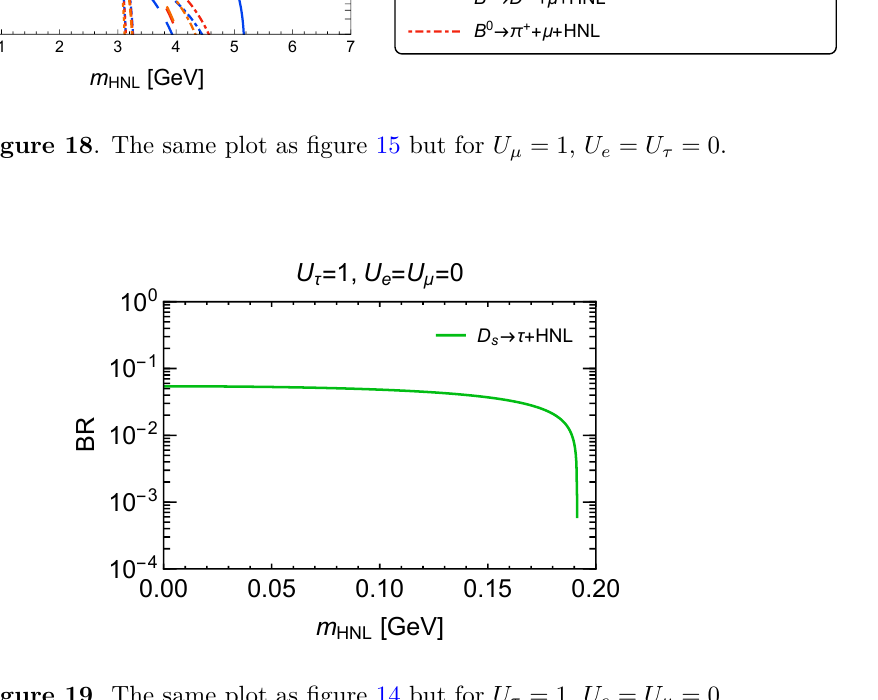
Figure 19 . The same plot as figure 14 but for U τ = 1 , U e = U µ = 0 .